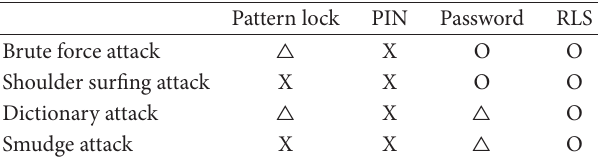
Table 5: Comparison of the existing locking systems and the RLS against various